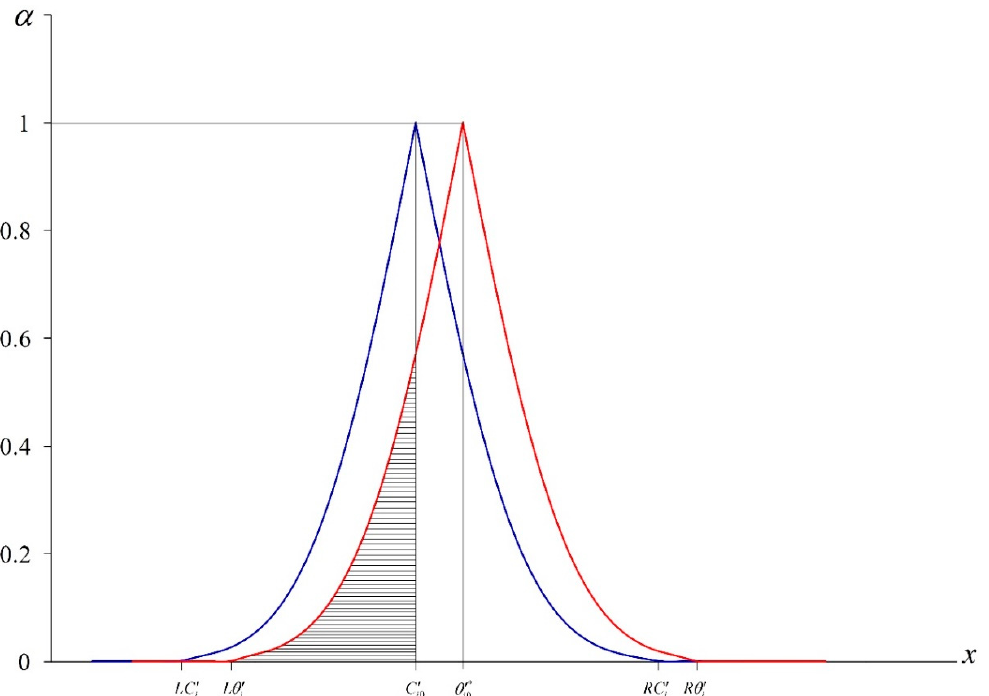
Figure 2. Membership functions of η (cid:48)